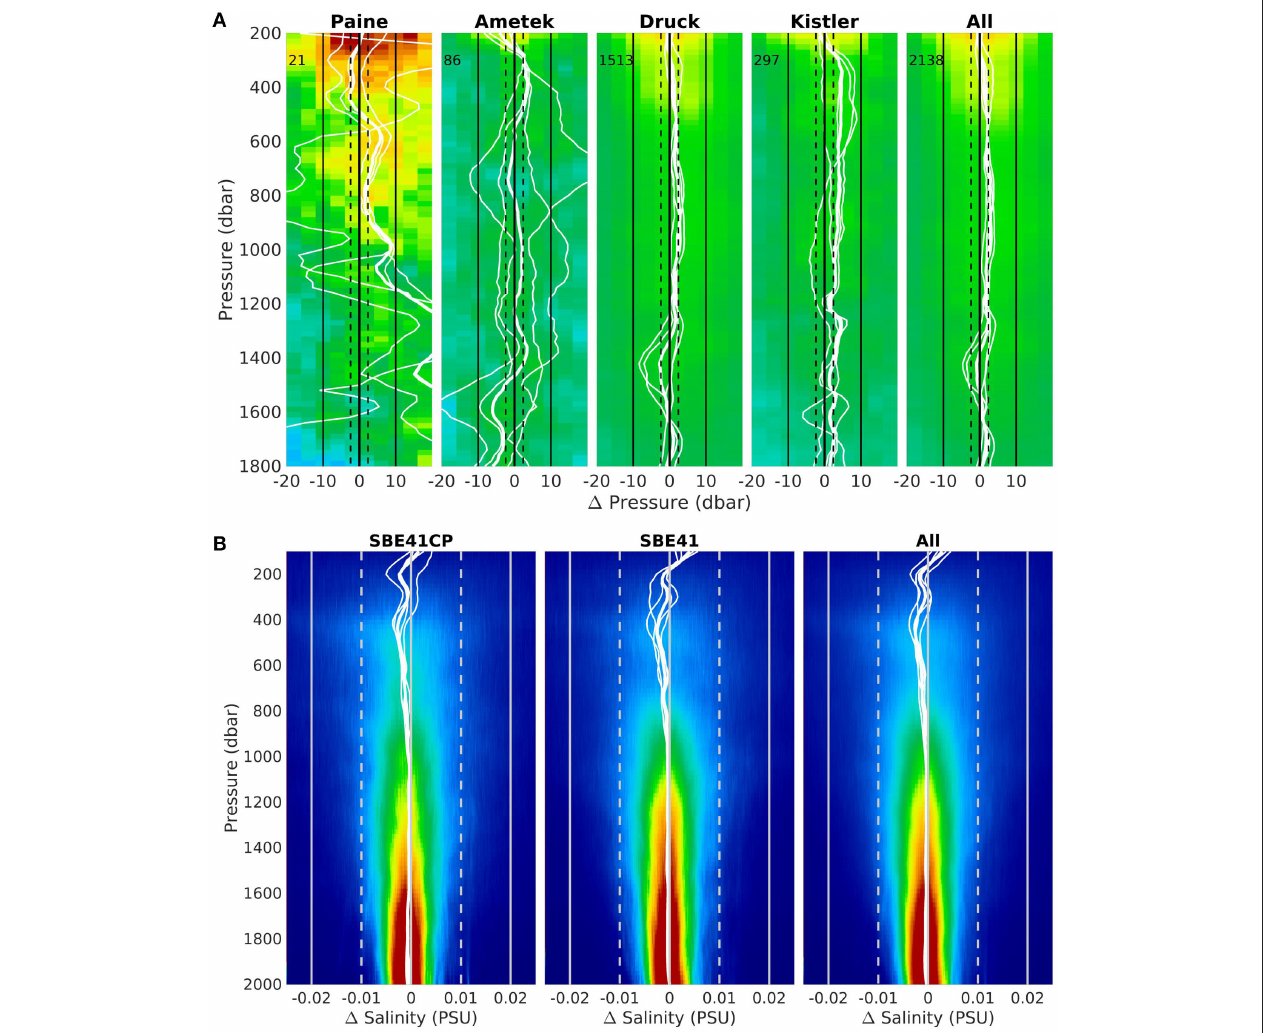
FIGURE 12 | Bias (Argo minus GO-SHIP) on σ 1 surface as a function of pressure (dbar). The thick white line is the median for all pairs in a cohort, and the thin white lines are the medians across the 4 hemispheres: east, west, north, and south. Colors qualitatively indicate the fraction of data in a bias bin for any given pressure (high fraction in red, low fraction in blue). (A) Median pressure bias (Argo minus GO-SHIP), for buddy pairs averaged by pressure sensor makers. Black dashed lines show the manufacturer accuracy specification on deployment of 2.4 dbar. The number of floats in each buddy cohort is marked in the top left-hand corner. (B) Median salinity bias (Argo minus GO-SHIP), for buddy pairs averaged by CTD types. Gray dashed lines show expected accuracy of 0.01